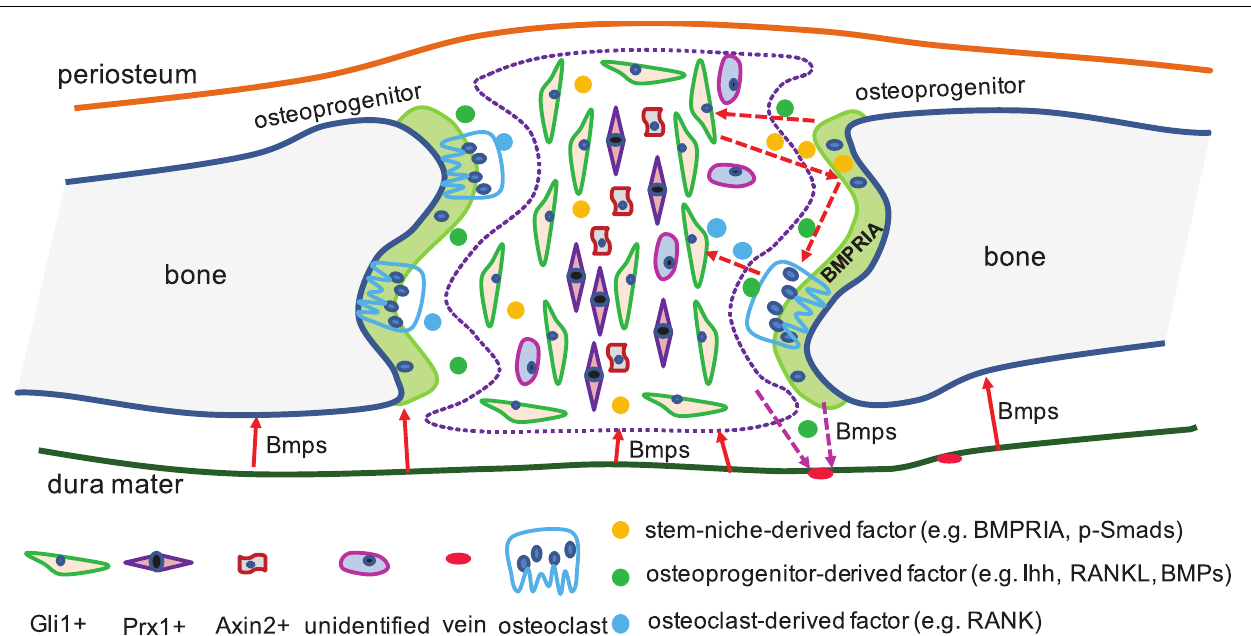
FIGURE 2 | BMP signaling interacts with different factors in suture-derived stem cells. In cranial sutures, identified and unidentified suture-derived stem cells were exhibited (The number of the labels indicate the population of stem-niche). Dura mater was found expressed BMPs which were required for the calvarial bone development (solid arrow in red). CNC- and mesoderm-derived preosteoblasts expressed BMPs (e.g., BMP2/BMP4), which were needed for the proper shaping of cerebral veins (dotted arrow in pink). Osteoprogenitors released Ihh, which was required by the suture-derived stem cells (e.g., Gli1+), and this process can be mediated by BMP signaling (dotted arrow in red). Besides, BMP mediating Ihh signaling and RANKL can work together to regulate the activities of osteoclasts (dotted arrow in red).